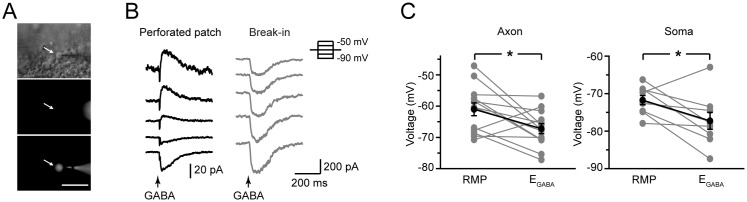
Reversal potential of GABA responses (EGABA) is more negative than the local RMP.A, Gramicidin perforated patch recording from an axon bleb. Arrow indicates the recorded bleb. Top, DIC image of the recording; middle, fluorescence image (unlabeled bleb); bottom, fluorescence image (labeled bleb, indicating rupture of patch membrane). Scale bar: 50 µm. B, Example traces showing GABA responses at different holding potentials (from –90 to –50 mV) before (black) and after the break-in (membrane rupture, gray). C, Comparison of EGABA and RMP. Note that EGABA at both the soma and the distal axon bleb were more hyperpolarized than their local RMP. *, P<0.05, paired t-test.